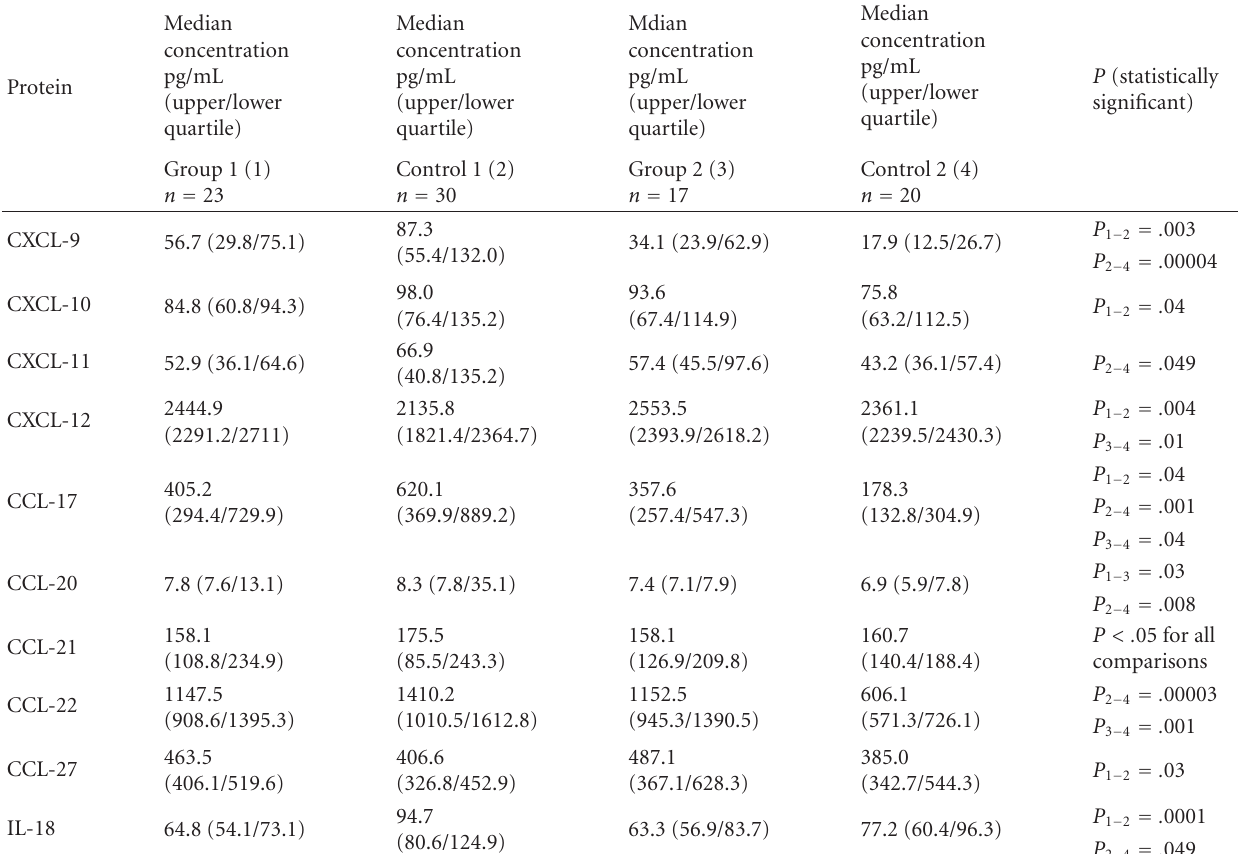
Table 2: Median serum concentration of analyzed chemokines in AD patients (Group 1 and Group 2) and Controls (Control 1 and 2). Protein